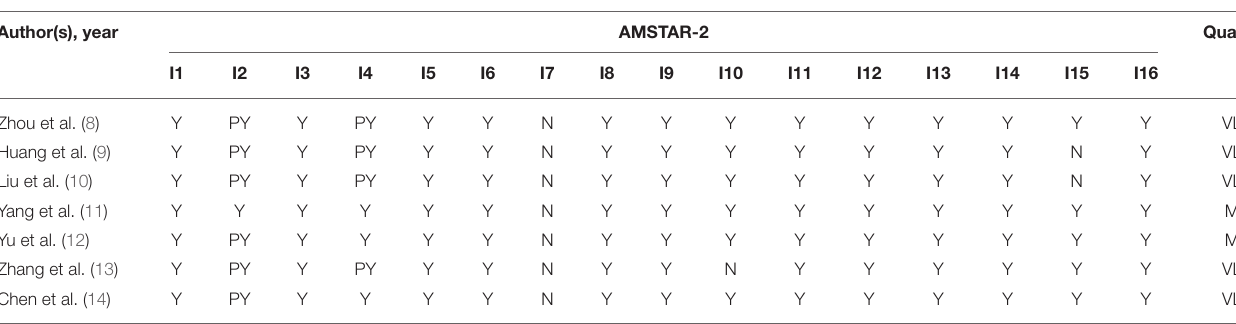
TABLE 3 | Results of the AMSTAR-2